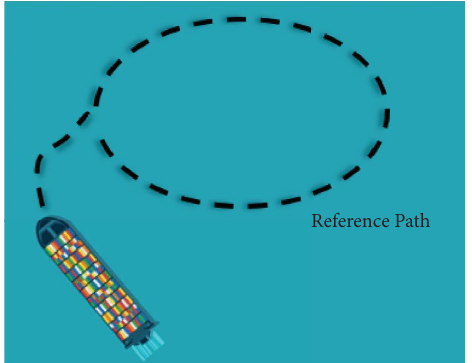
Figure 2: Second scenario